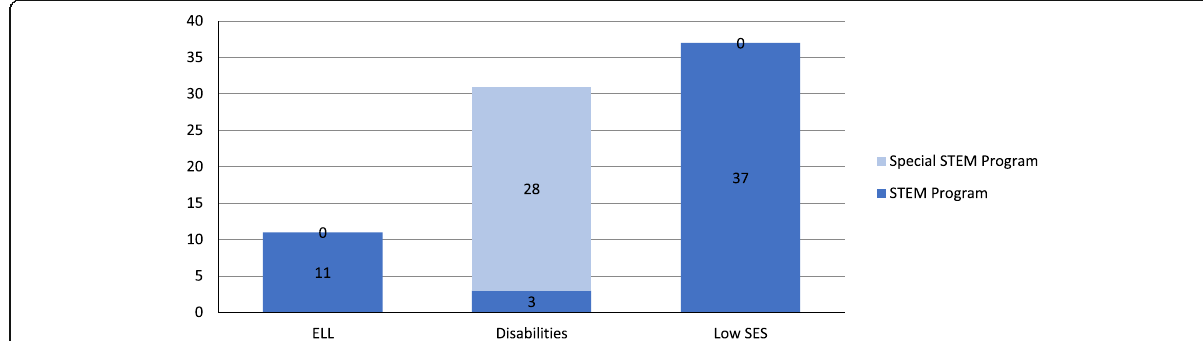
Fig. 13 The number of funded projects in STEM education for three special participant populations (Note: ELL: English language learners, Low SES: low social-economic